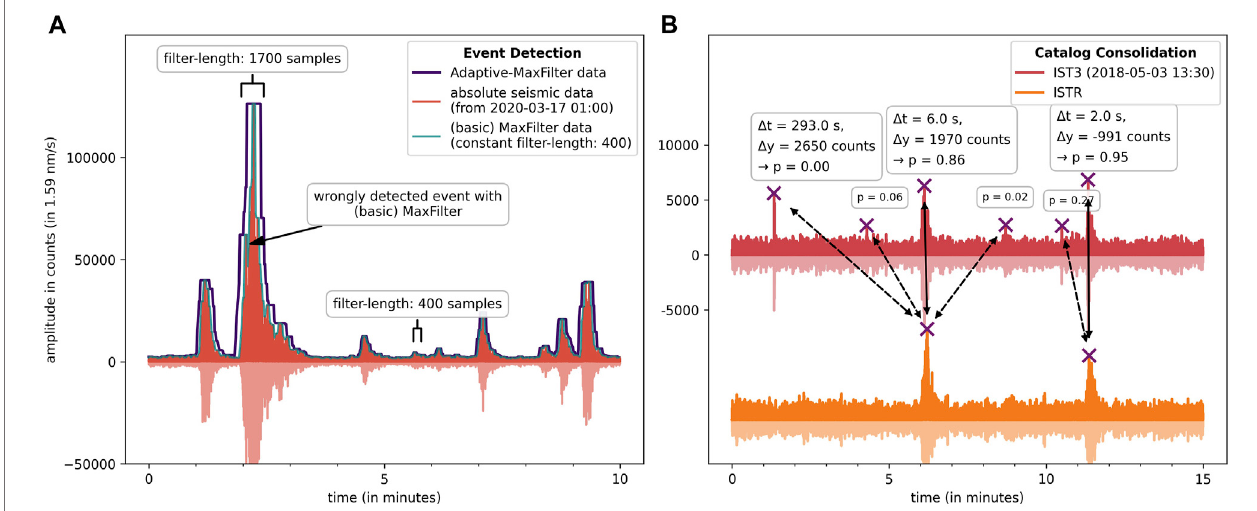
FIGURE4|(A) AdaptiveMaxFilter.Thekernelsizeisadaptivelycomputedfromthemeanoftheabsolutedata,whichenablestoreliablydetecttheseismo-volcanic events of all amplitudes. (B) Catalog consolidation executed on example data to validate the generated catalogs with the signal from a second station. The arrows indicate the closest seismo-volcanic events detected at both stations, from which the distance and probability are computed. The dashed arrows denote that the two events do not correspond to each other. Note that the algorithm only uses the catalogs, the seismic data is just displayed for visualization.